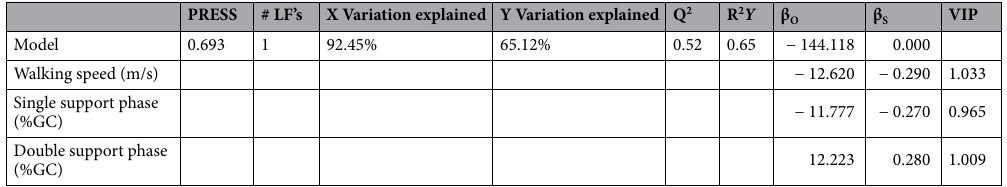
Table 3. Results of the partial least squares model for the AP MoS in BVP-patients. AP MoS: Anterior– posterior margin of stability; PRESS: Predictive Residual Sum of Squares; # LF’s: number of Latent Factors; Q 2 : goodness of prediction; R 2 Y : goodness of fit; β O : regression coefficient for original data; β S : regression coefficient for centred and scaled data; VIP: Variable Importance in Projection; m/s: metres per second; %GC: percentage of gait cycle.